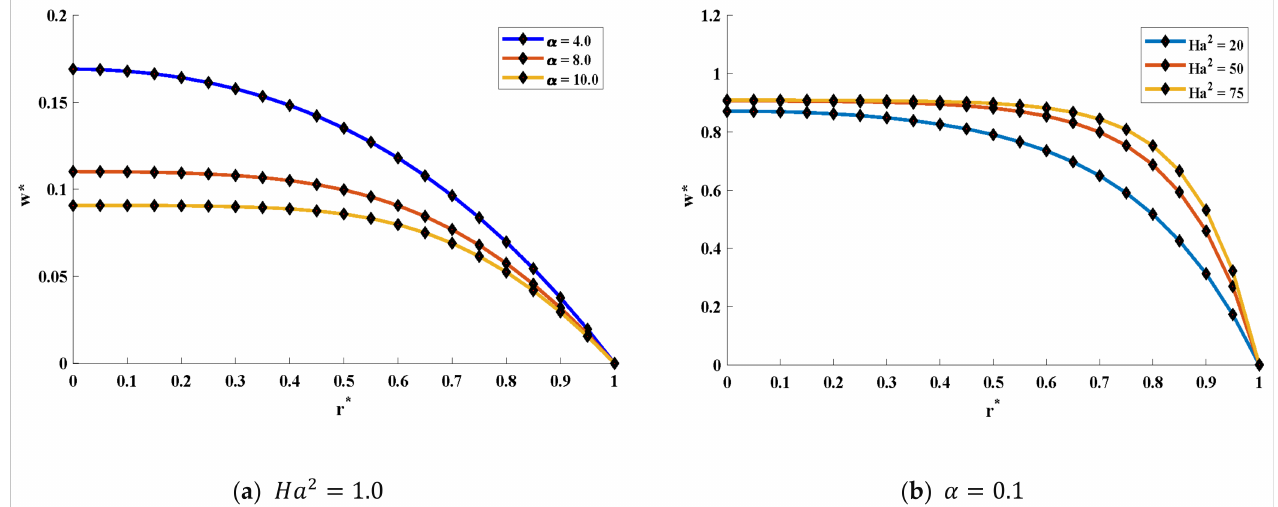
Figure 7. Results of velocity profile for the EHD flow of fluid with larger valu es of ( a ) the nonlinearity parameter and ( b ) Ha 2 achieved by the proposed algorithm.